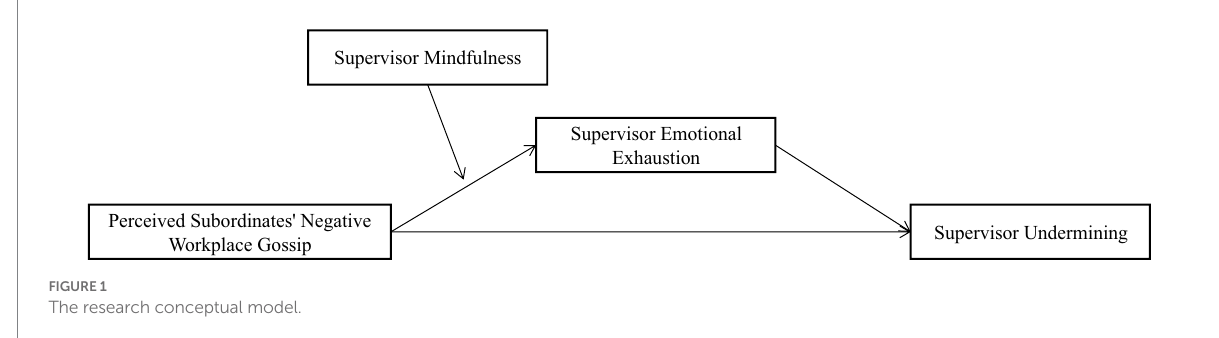
FIGURE 1 The research conceptual